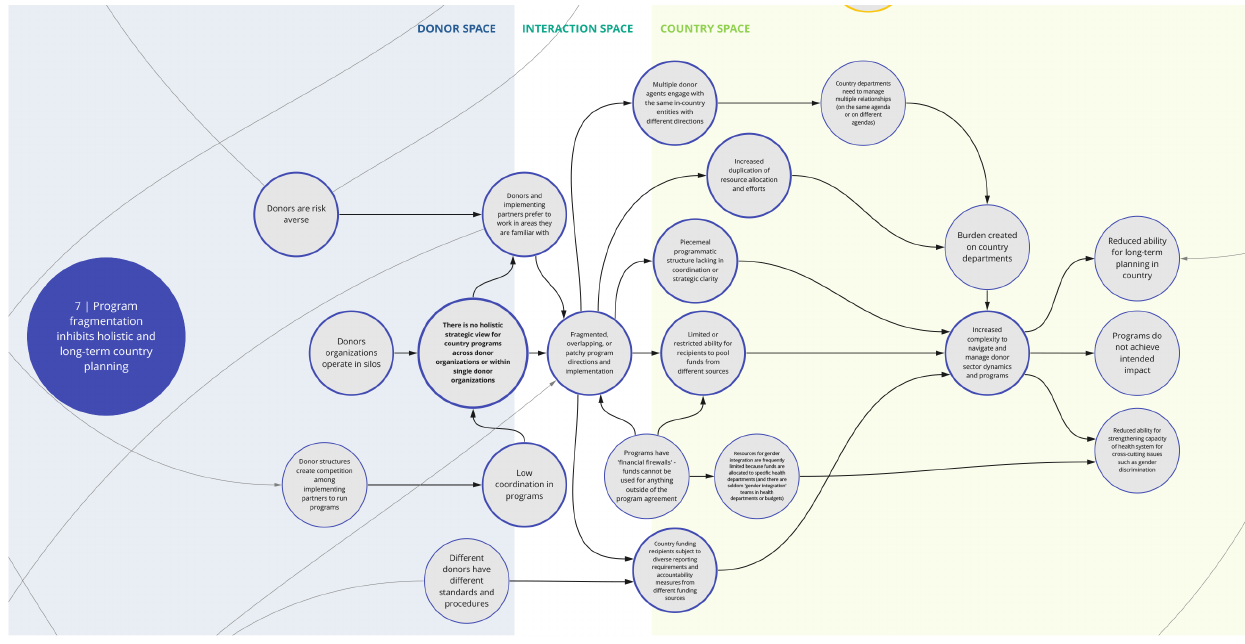
Figure 8. Syndrome 7: Program fragmentation inhibits holistic and long-term country